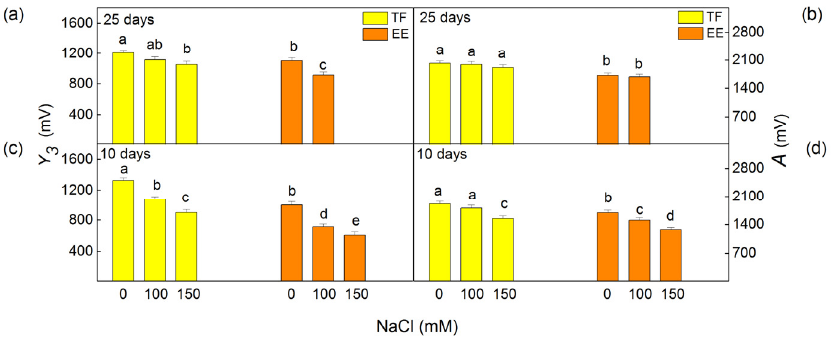
Figure 4. Influence of different NaCl concentrations on the PSII activity (H 2 O → BQ) ( a , c ) and PSI activity (DCPIPH 2 → MV) ( b , d ) in isolated thylakoid membranes from leaves of Paulownia tomentosa x fortunei (TF) and Paulownia elongata x elongata (EE). The plants were treated after 10 and 25 days. Mean values (±SE) for the given parameter marked with different letters have statistically significant differences at p < 0.05.